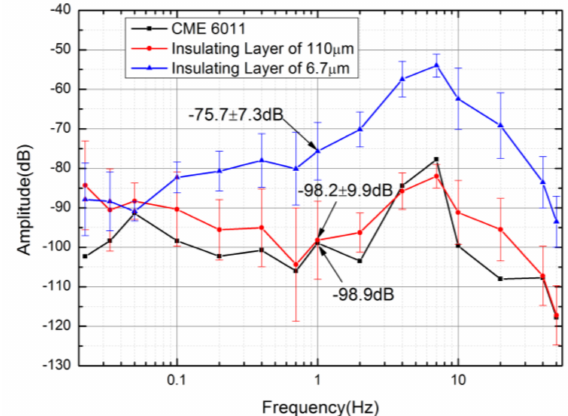
Figure 6. The self-noise power spectrums of electrochemical seismic sensors that relied on parylene and silicon substrates, respectively, as well as commercial seismic sensor CME6011. The self-noise levels of the seismic sensors based on the parylene substrate were about 82.3 ± 3.8 dB@ 0.1 Hz, 75.7 ± 7.3 dB@ 1 Hz, and 62.4 ± 7.7 dB@ 10 Hz, which were higher than those of the seismic sensors based on the silicon